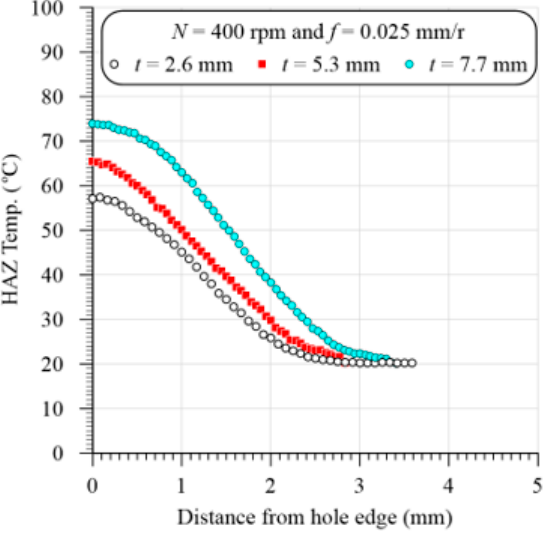
Figure 5. Representative sample of the temperature distribution of HAZ of GFRP specimen with different thicknesses at 400 rpm and 0.025